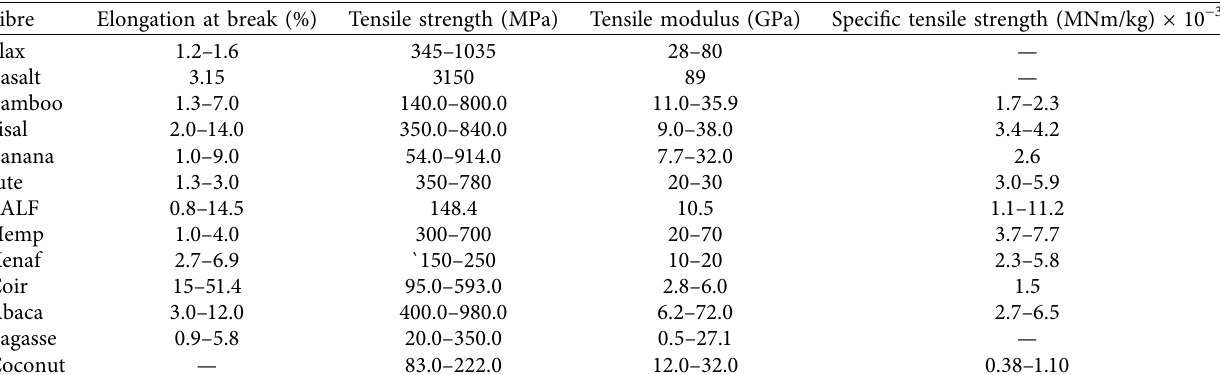
Table 3: Mechanical properties of selected natural fibres [14, 47, 48,